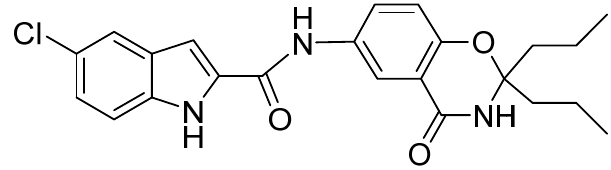
Figure 1. The structure of compound 1 .